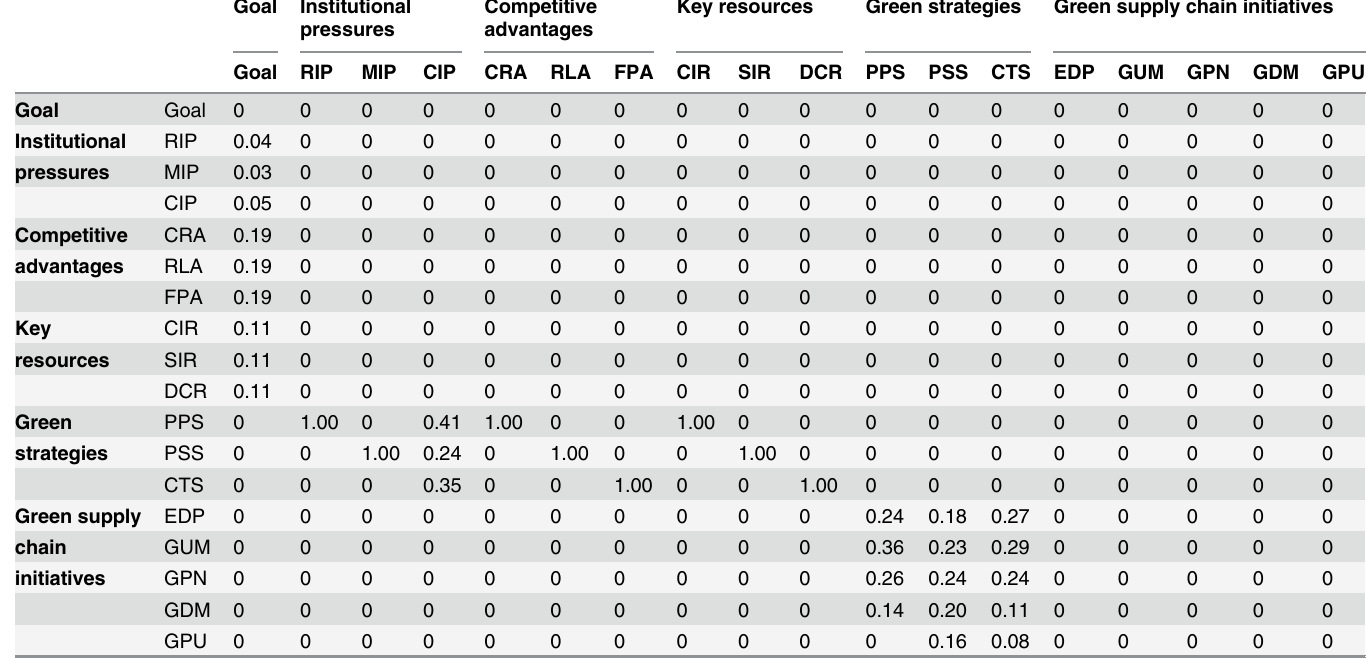
Table 9. Weighted supermatrix.